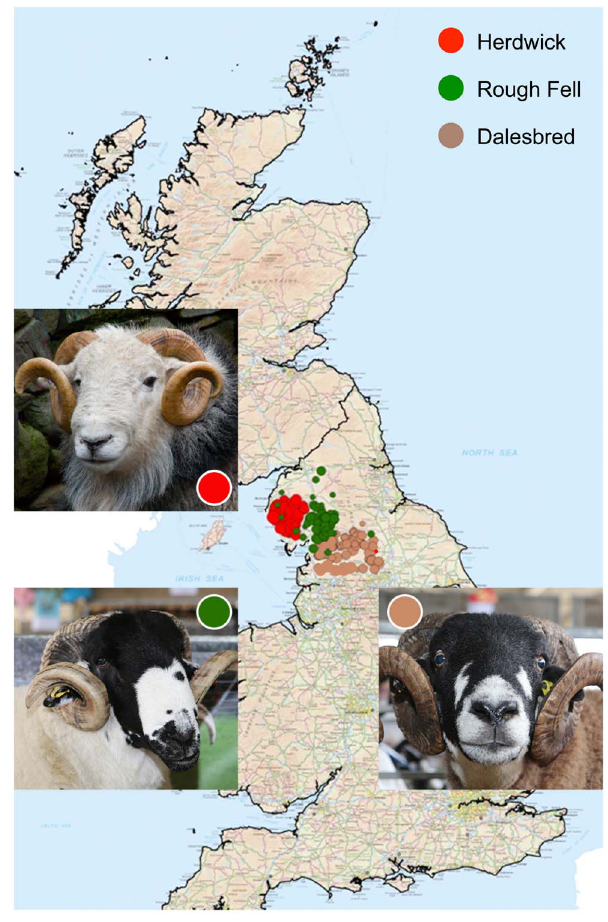
Figure 1. The distribution of three locally adapted sheep breeds of the UK uplands and their geographical concentra- tion shown on a composite map using data described in [ 8 ] .